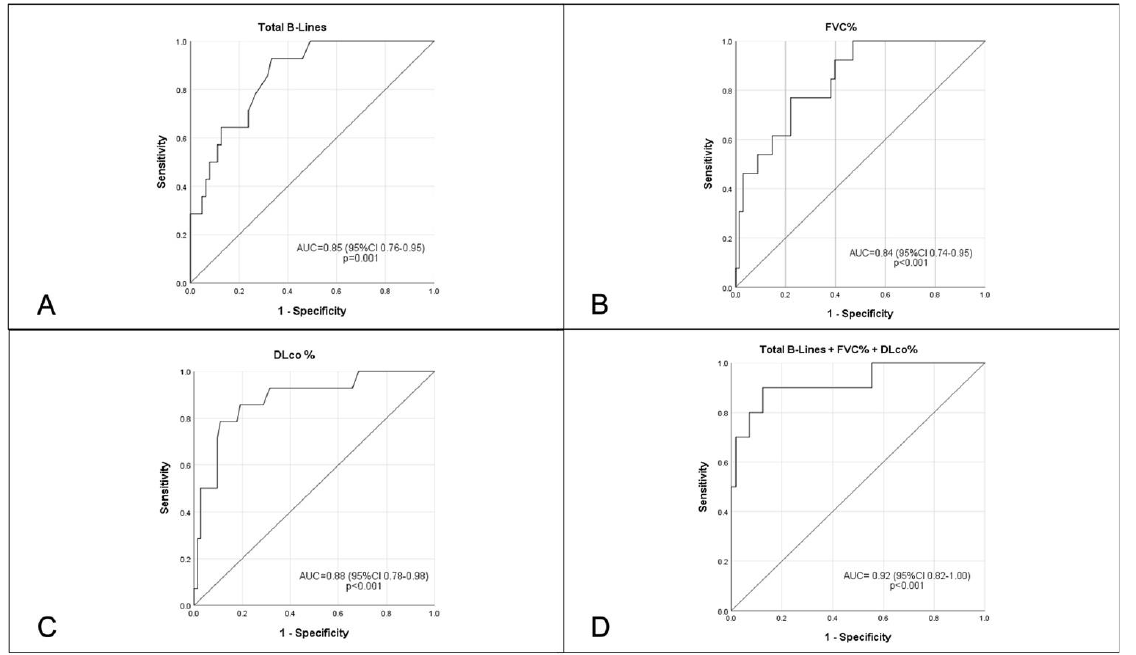
Figure 3. Receiver Operating Characteristics curves for the prediction of presence of extensive interstitial lung disease on high-resolution computed tomography, including Total B-lines (Panel A ), FVC% (Panel B ), DLco% (Panel C ) and the combination of FVC%, DLco% and Total B-lines (Panel D ). DLco% = diffusion lung capacity of carbon monoxide; FVC% = forced vital capacity.